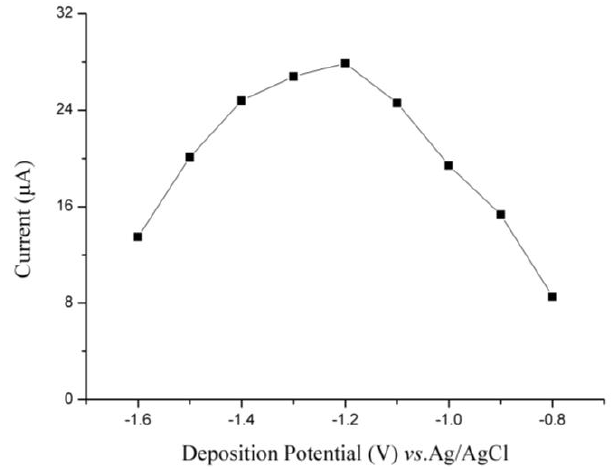
Figure 7. Effects of deposition potential on the stripping peaks current of 35 µg/L Cd(II).